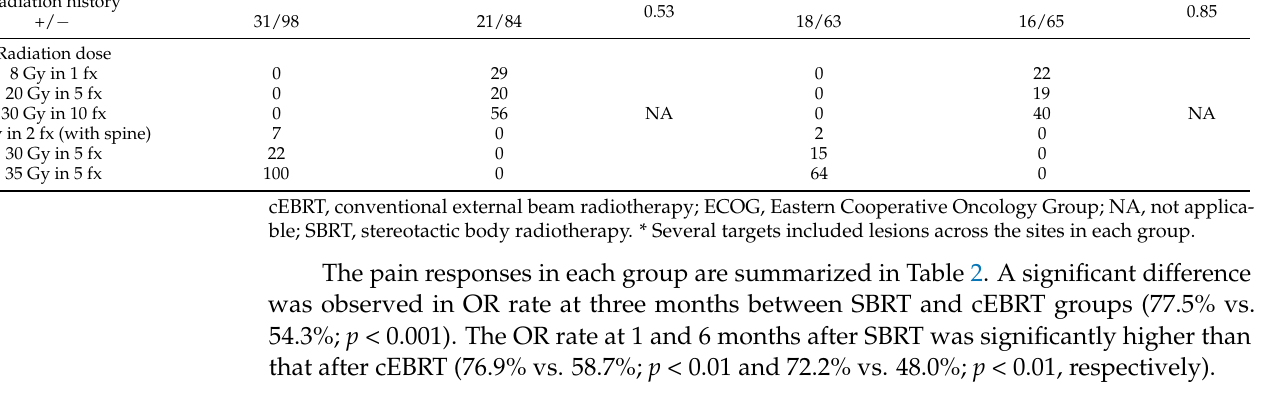
Table 2. Pain response over